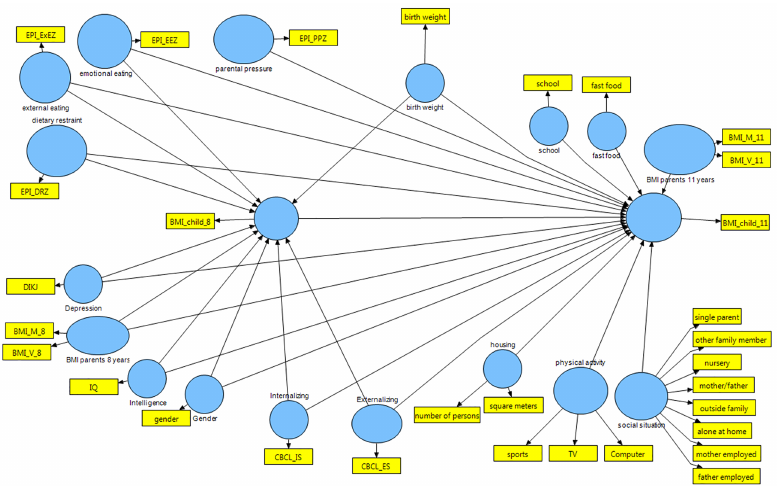
Fig 2. Partial Least Squares Structural Equation Model (PLS-SEM) predicting children´s BMI at 11 years.